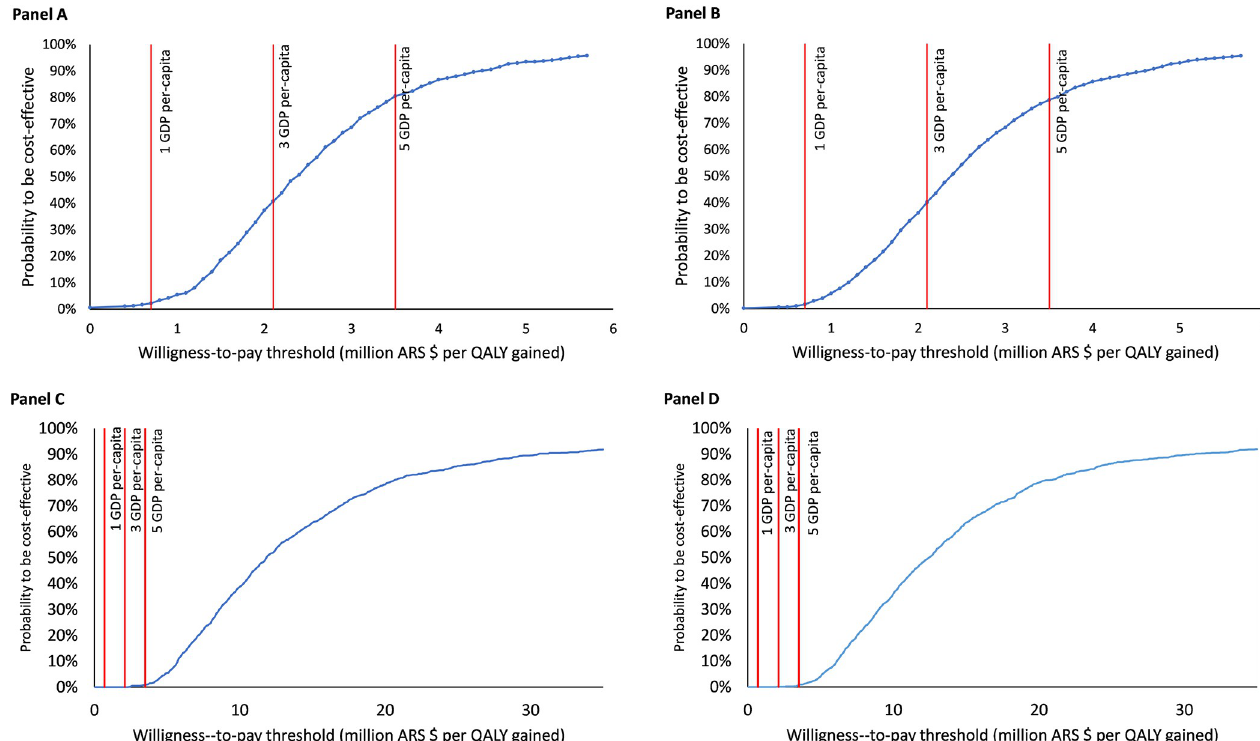
Fig 4. Cost-effectiveness acceptability curves for the centrifugal-flow pump as destination therapy (DT). Results for Social Security and Private Sector perspectives are displayed in Panel A and Panel B. The cost-effectiveness acceptability curves for a centrifugal-flow pump as bridge-to-transplant (BTT) are reported in Panel C (Social Security perspective) and Panel D (Private Sector